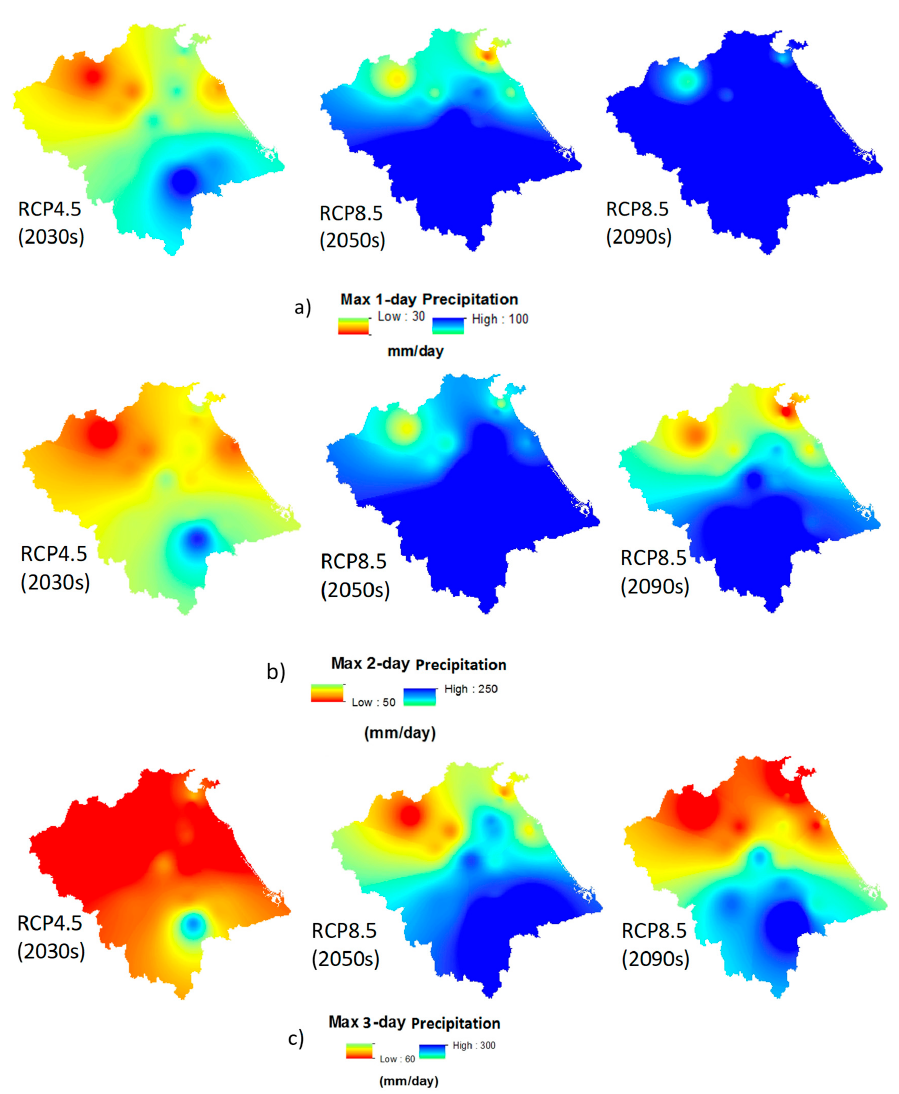
Figure 6. Projected changes of maximum 1- ( a ), 2- ( b ) and 3- ( c ) days under climate change scenarios.